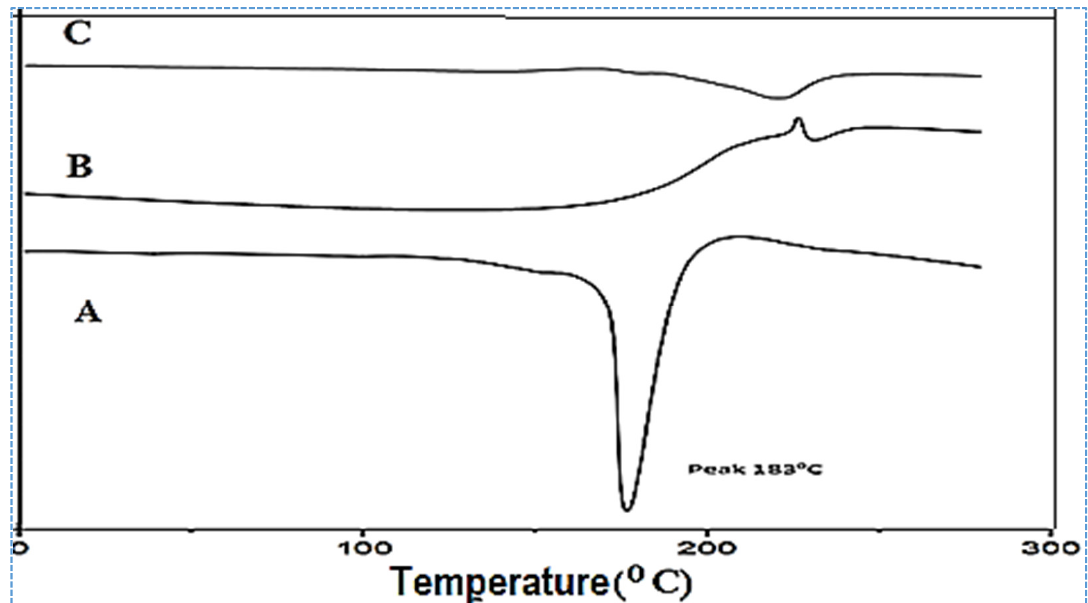
Figure 6. DSC thermogram of pure ALG ( A ), Eudragit RSPO ( B ), and optimized ALG-NPs ( C ).